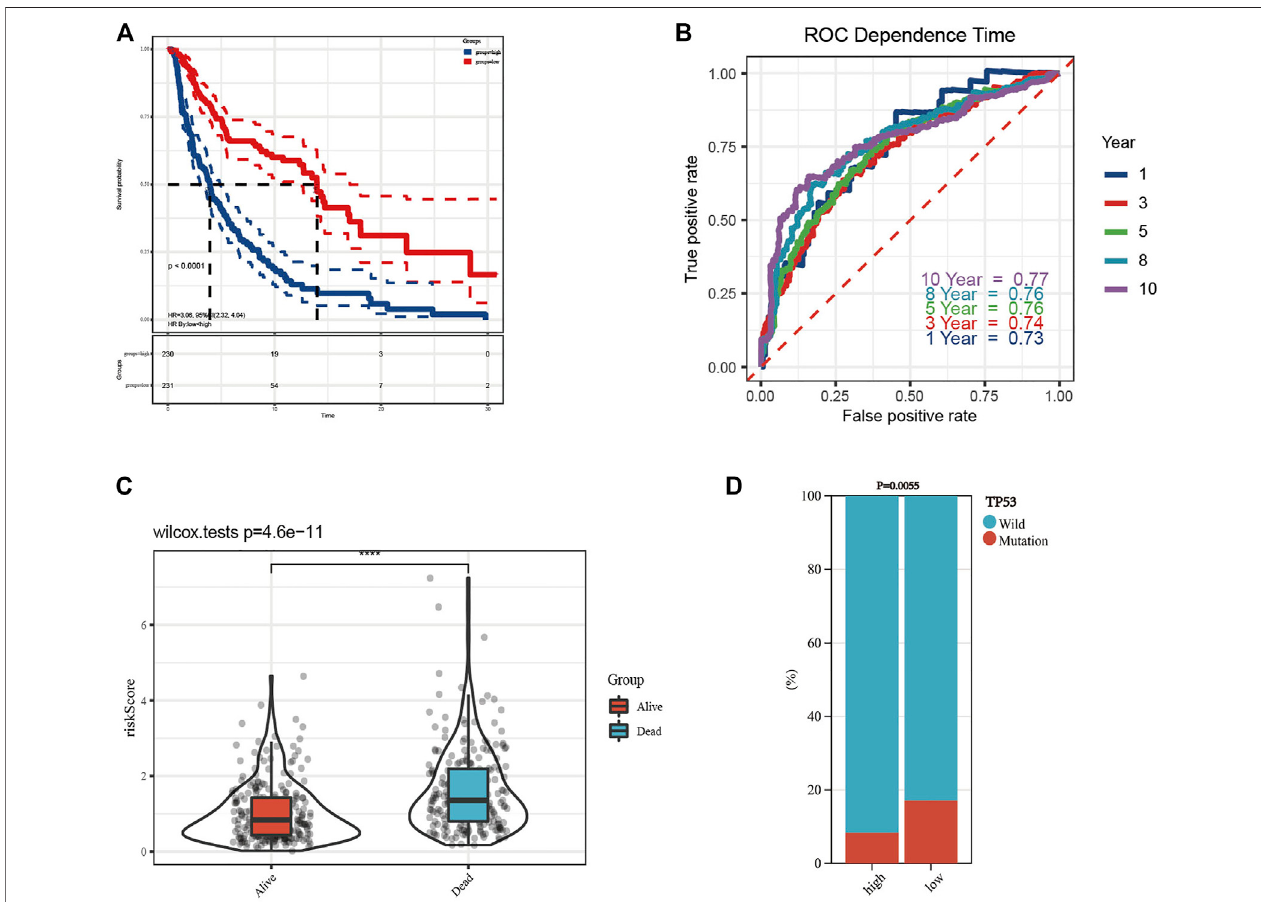
FIGURE5| Construction ofprognostic model and survivalanalyses. (A) TheKaplan – Meier(K-M)overall survival curves inthe high-and low-riskgroup. (B) The 1-, 3-, 5-, 8-, and 10-year receiver operating characteristic (ROC) curves of the prognostic model. (C) Risk scores of patients with different survival outcomes were of signi fi cant difference. (D) The difference of TP53 mutation state between the high- and low-risk groups was statistically signi fi cant.